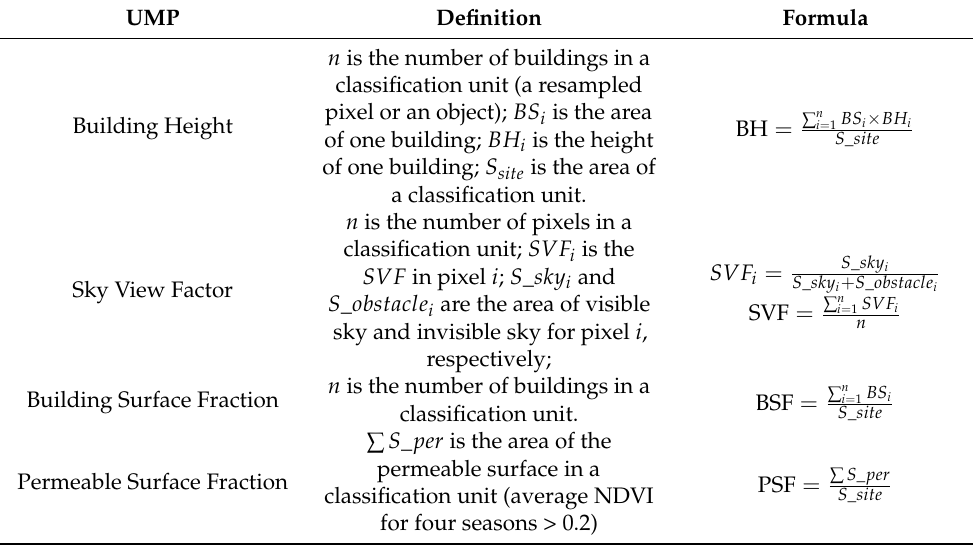
Figure 4. The calculation of SVF. SVF is the visible proportion of the sky hemisphere. S_sky and S_obstacle are the visible sky and invisible sky. The angle ( θ ) and the search radius (R) are determined by the highest building in the search range and users’ definition, respectively. Table 3. Urban morphological parameters. In this study, the final UMPs for mapping were extracted from mapping units.